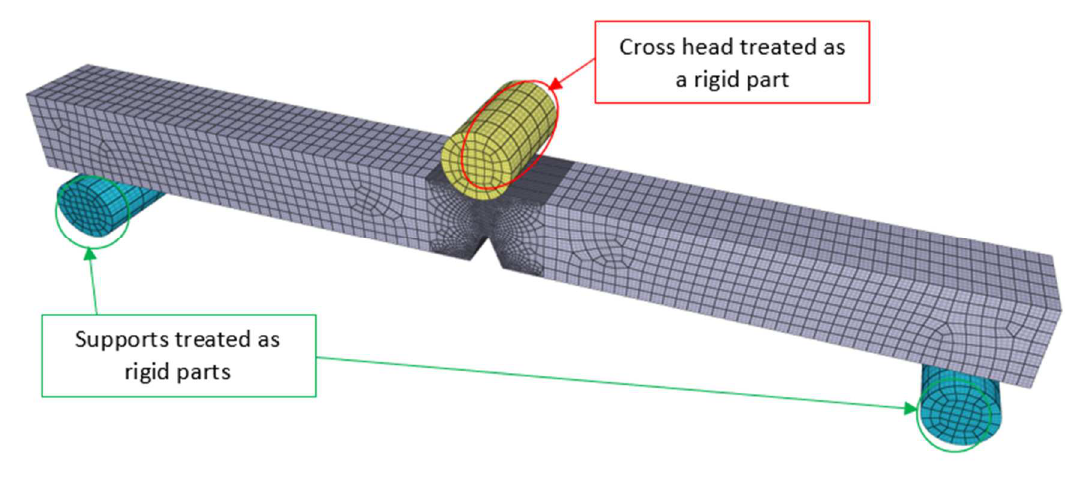
Fig. 3. Generic computing model used for all quasi-static simulations